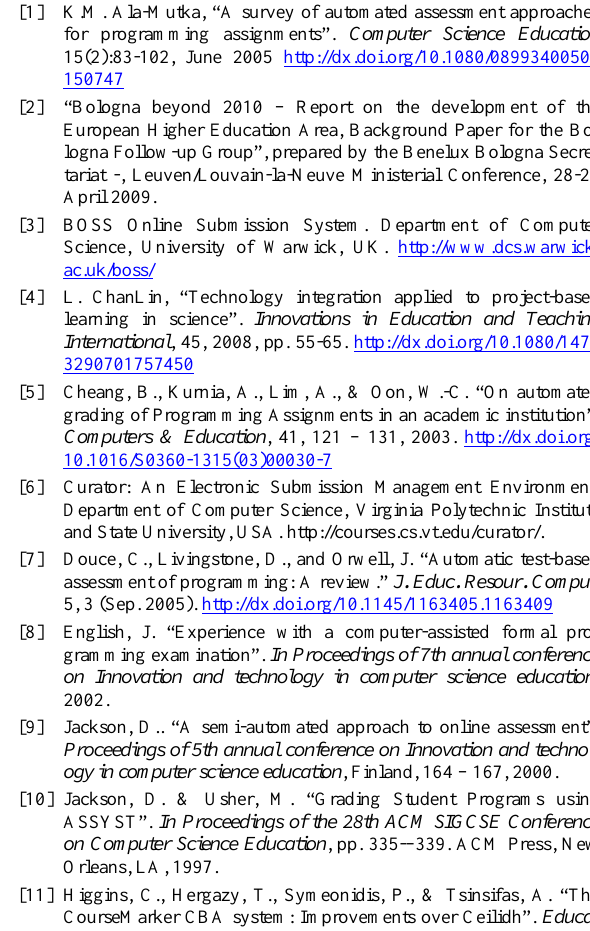
Figure 4. Results in FED: the four options.